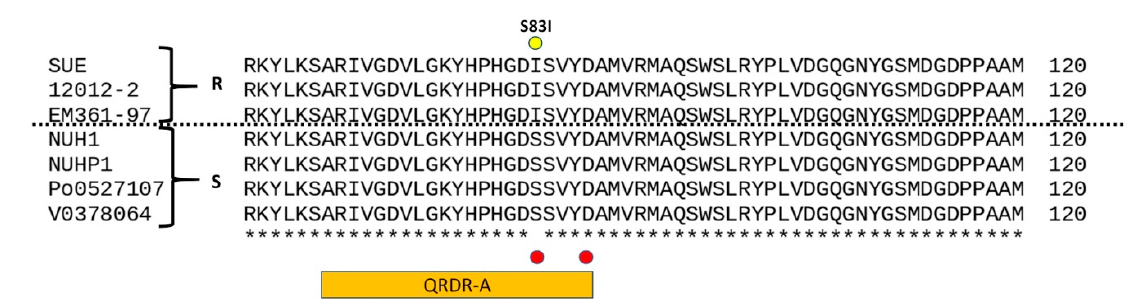
Figure 3. Sequence alignment of seven E anopheles DNA gyrase subunit A orthologs. Residues marked in red dots are sites of common quinolone drug resistance mutations. The yellow dot indicates a specific residue mutated in the current study, which was Isoleucine in the three quinolone-resistant strains and Serine in the four quinolone-sensitive strains QRDR-A are boxed in an orange bar.